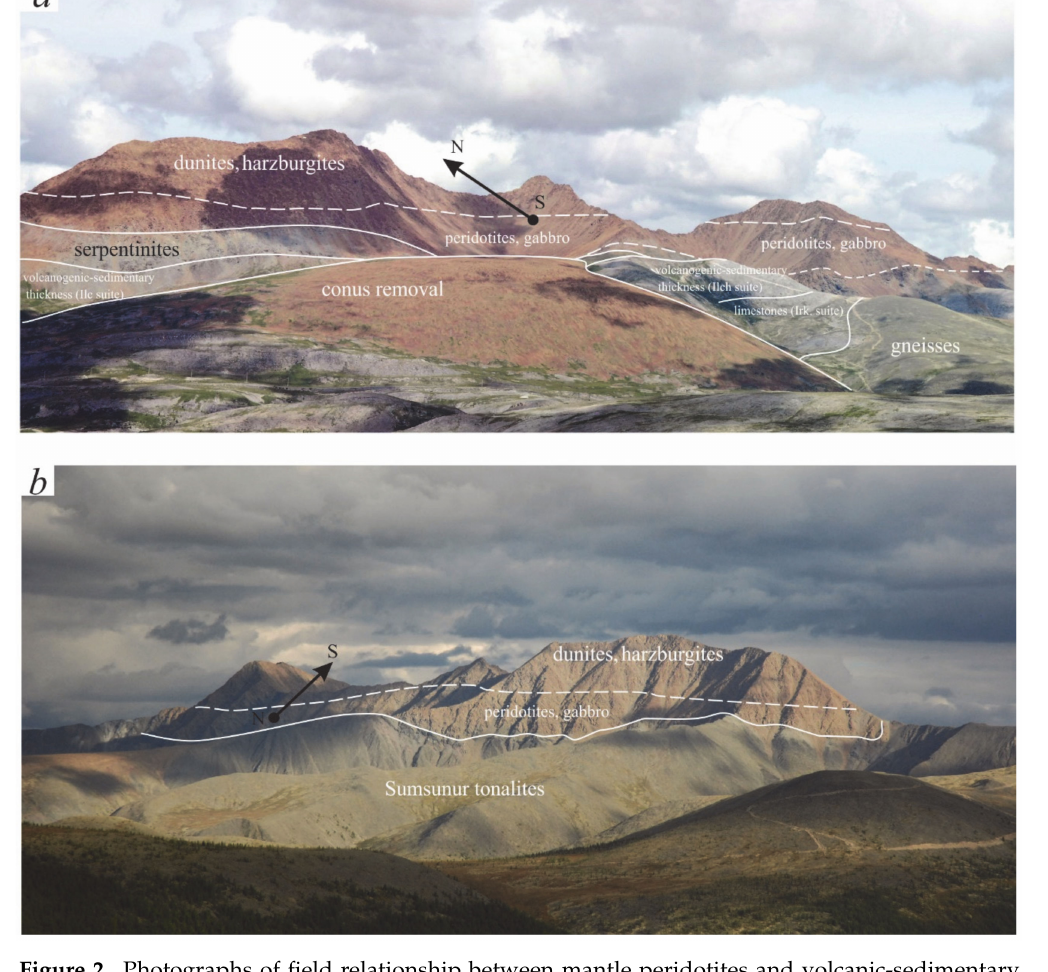
Figure 2. Photographs of field relationship between mantle peridotites and volcanic-sedimentary sequence (Ilchir suite), limestone (Irkut suite), Gargan gneisses, and Sumsunur tonalites: ( a ) View of the south side of the Ulan-Sar’dag m é lange (USM) and ( b ) view at the north side of the Ulan-Sar’dag m é